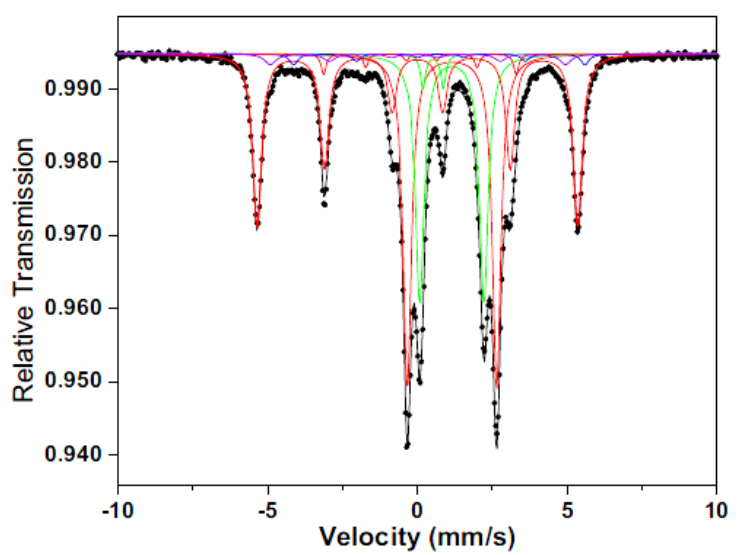
Figure 2. Room temperature Mössbauer spectra of the Almahata Sitta anomalous ureilite. Indicated spectral components are the result of the fit. Adapted from [7].